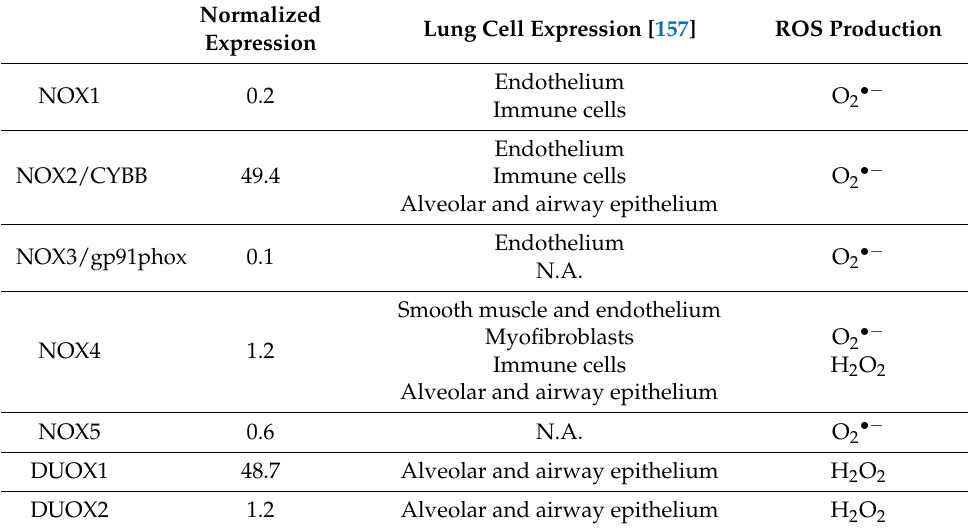
Table 2. Expression profile of NADPH oxidase homologs in the lung. Normalized